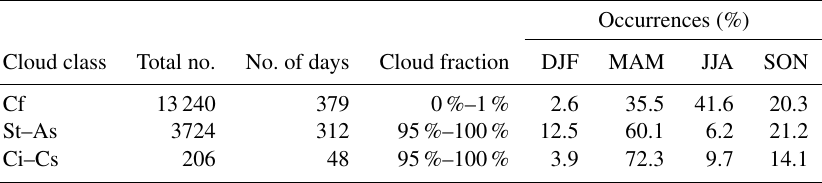
Table 1. Summary of the total number of measurements, number of days, cloud fraction considered and the occurrences per season (DJF: winter, MAM: spring, JJA: summer, SON: autumn) for cloud-free (Cf), stratus–altostratus (St–As) and cirrus–cirrostratus